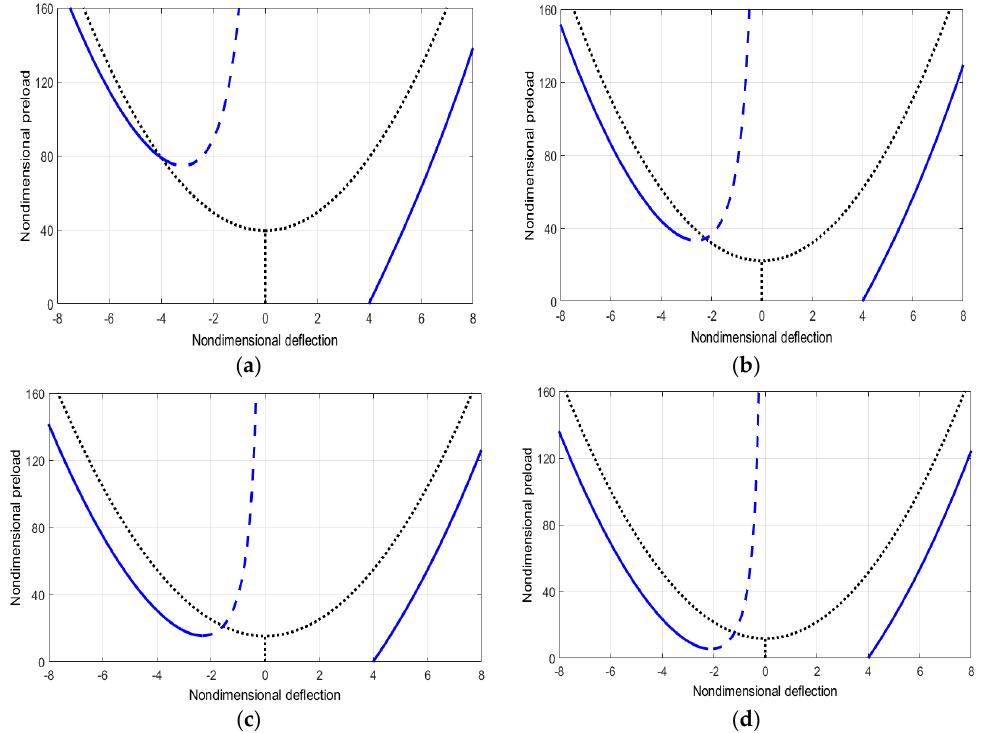
Figure 9. Variation of the static deflection with the pre-load at a = 4 and α = 1. ( a ) µ = 0.0; ( b ) µ = 0.02; ( c ) µ = 0.04; ( d ) µ =